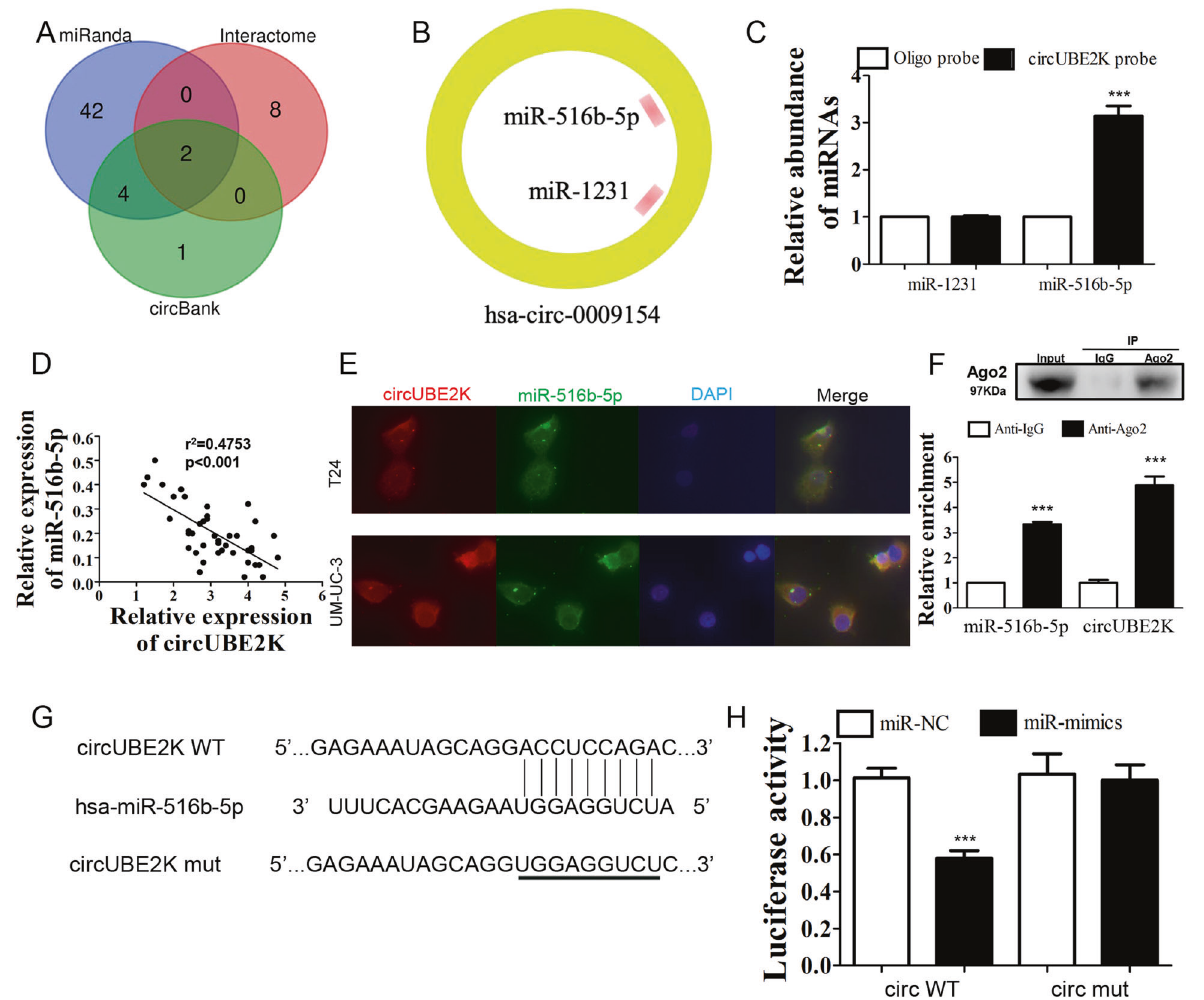
Fig. 3 circUBE2K acted as a sponge for miR-516b-5p in BC cells. A Venn diagram showing overlapping of potential targets of circUBE2K predicted by miRanda, Circular RNA Interactome and CircBank Database. B Two miRNAs (miR-516b-5p and miR-1231) were predicted by three different prediction software programs. C RNA-pulldown assay followed by qRT-PCR suggested interaction between circUBE2K and miR-516b- 5p. Error bars indicate SD ( *** P < 0.001 vs. other groups). D Scatter plot presented negative correlation between expression level of circUBE2K and miR-516b-5p in BC tissues ( n = 42, r 2 = 0.4753, P < 0.001). E Co-localization of circUBE2K (Red) and miR-516b-5p (Green). Nuclear staining was performed using DAPI (Blue). F RIP experiments were performed in T24 cells against IgG or Ago2, and the precipitated circUBE2K and miR- 516b-5p were detected by qRT-PCR. *** P < 0.001 vs IgG. G Predicted binding site of circUBE2K and miR-516b-5p was demonstrated. The third row showed mutated circUBE2K sequence for further dual-luciferase reporter assay. H Luciferase activity were measured after